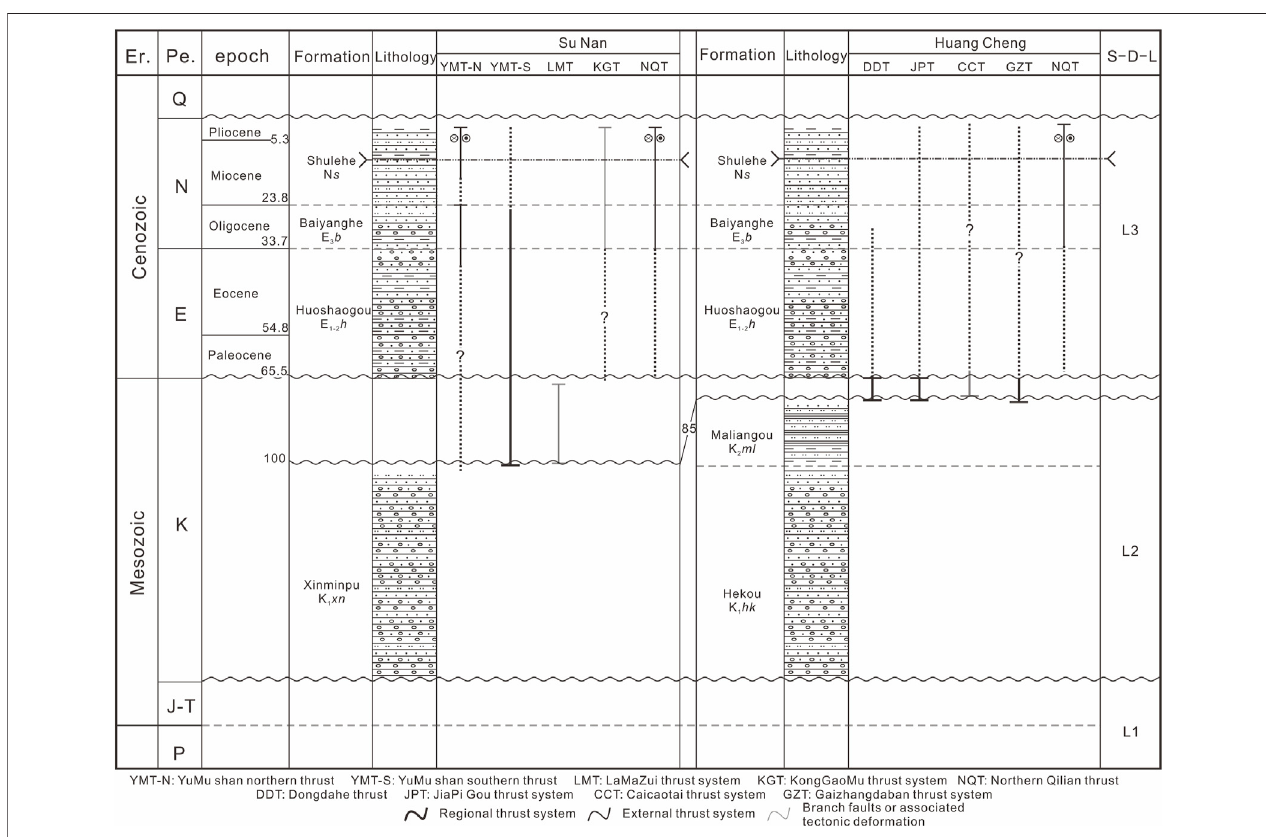
FIGURE 2 | Chronology of thrust faulting and sequence stratigraphy in Sunan and Huangcheng. Lithologic age constraints were obtained from the Bureau of Mineral Resources of Gansu Province (BMRGP, Regional Geological Survey) (1982). The time of faulting are based on the faults, strata and unconformity contacting relations from the geological map (Bureau of Mineral Resources of Gansu Province (BMRGP, Regional Geological Survey), 1982; BMRIMP, 1991; Bureau of Mineral Resources of Qinghai Province (BMRQP, Regional Geological Survey), 1991) and the fi eld observation.